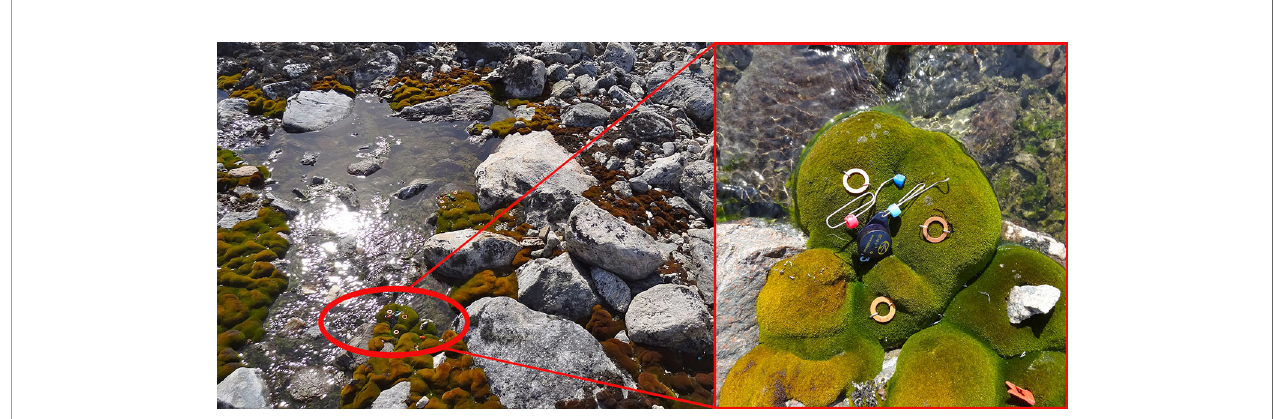
FIGURE 2 | A typical wet site abutting a melt stream at the Red Shed site at Casey (left). Close up (right) shows iBCod sensor setup on a